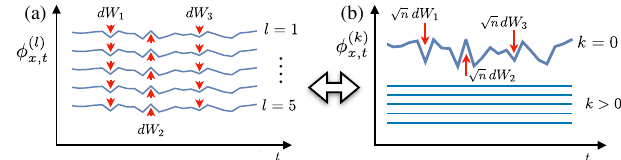
FIG. 4. Illustration of the coupling of the fields ϕ to the X measurement noise at a fixed position x and for different times t . (a) In the replica basis f ϕ ð l Þ σ g , each field couples to the same ;X (spatiotemporal) measurement noise dW (the individual t fields are given an offset with respect to each other for better visibility). (b) In the Fourier basis f ϕ ð k Þ σ g , defined in Eq. (67), the ;X k ¼ 0 or center-of-mass mode couples to an enhanced noise ffiffiffi p n dW while all the relative modes ( k > 0 ) decouple from dW t t and are